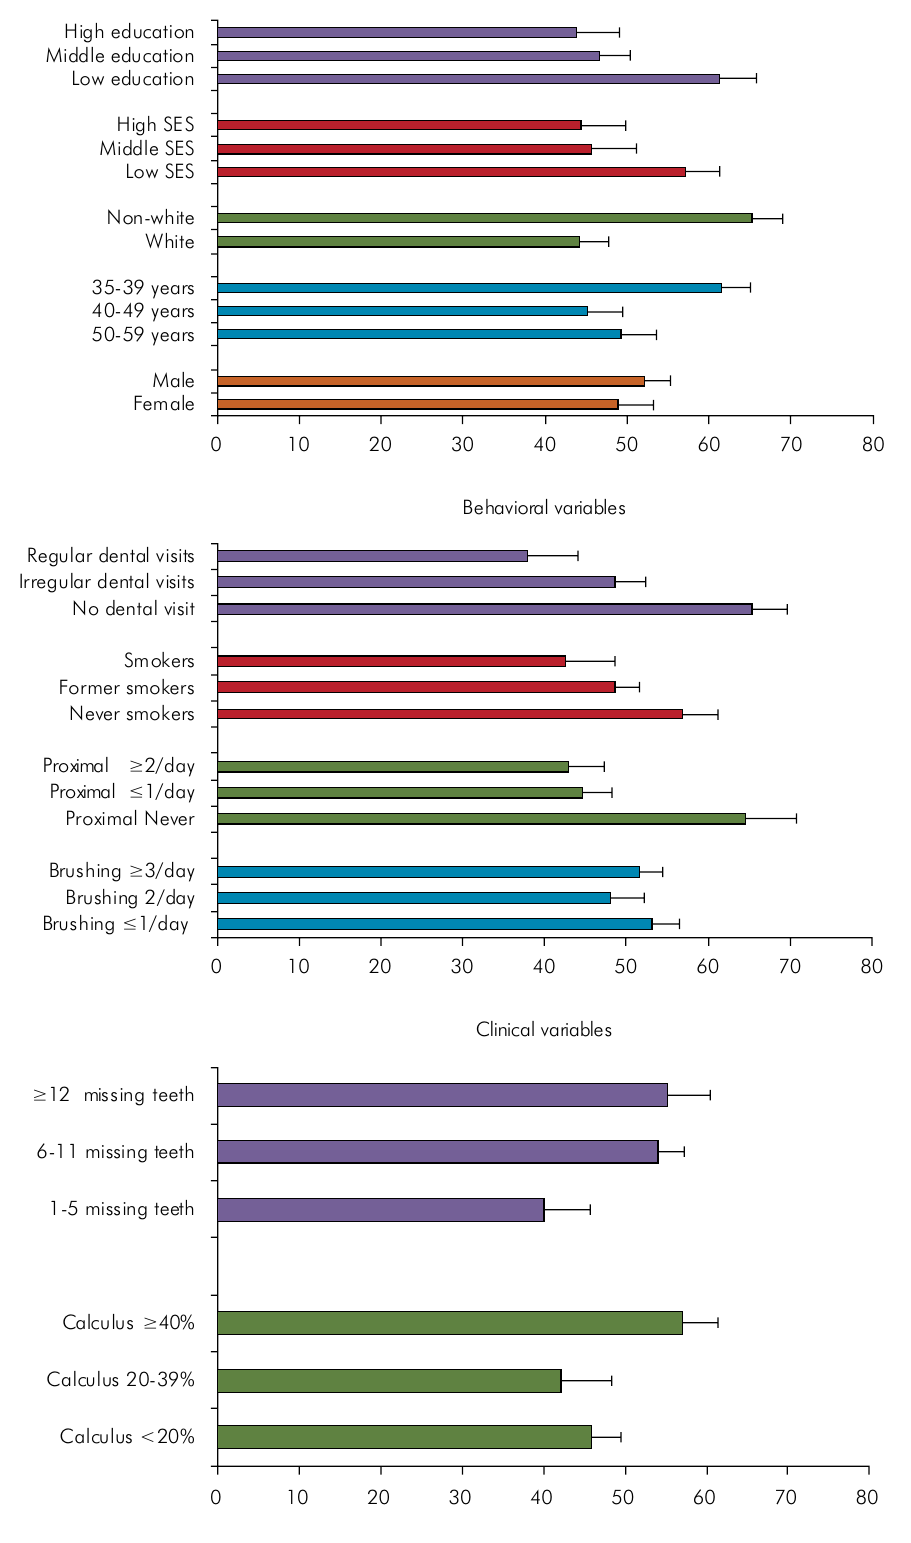
Figure 3. Distribution of individuals with gingival bleeding ≥20% according to demographic, behavioral and clinical variables.